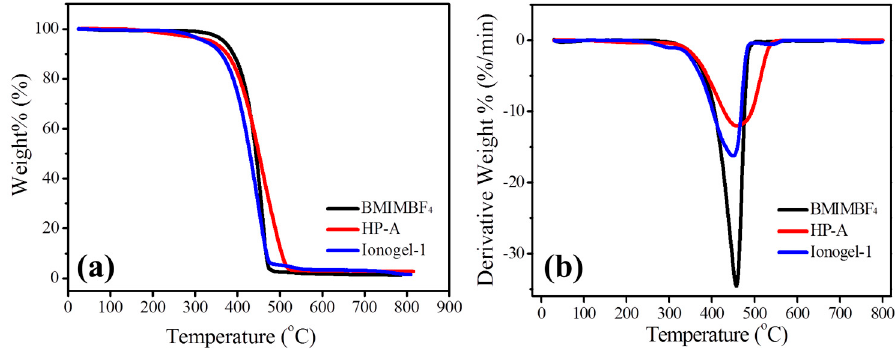
Figure 4. ( a ) TGA and ( b ) DTG curves of BMIMBF 4 , HP-A and ionogels.